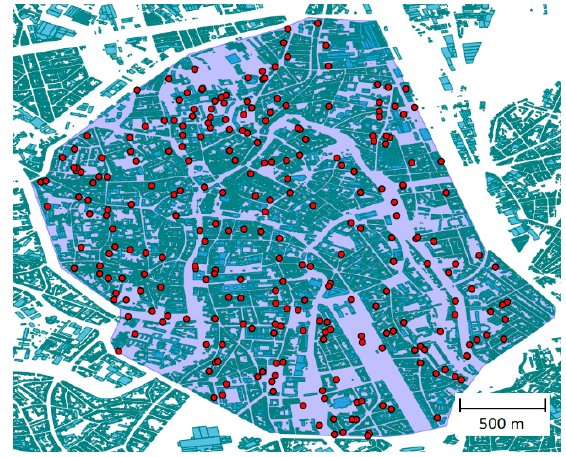
Figure 2. The city center of Ghent with 260 ground users in red circles.